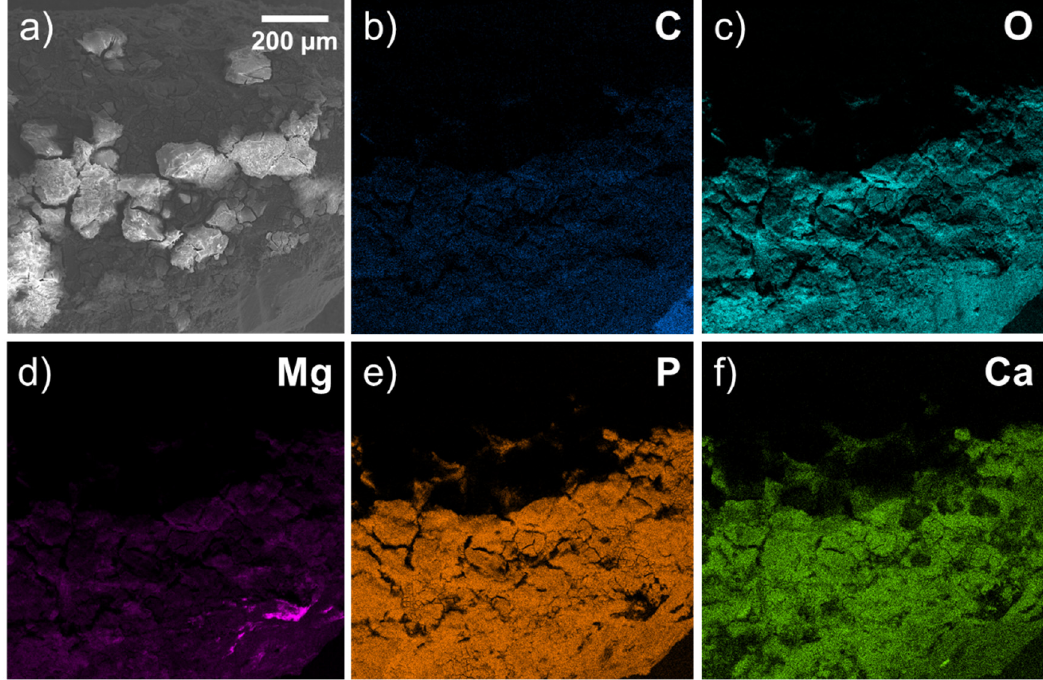
Figure 7. EDX image of surface relief of implant site after 1 month: ( a ) SEM image of bone surface; ( b – f ) elemental maps.